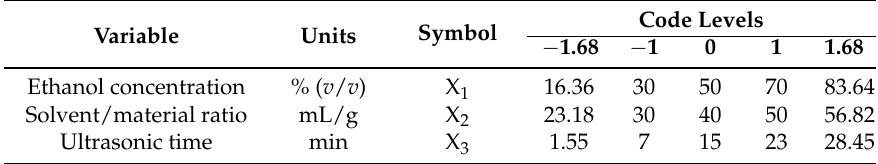
Table 5. Variables and their five levels employed in central composite rotatable